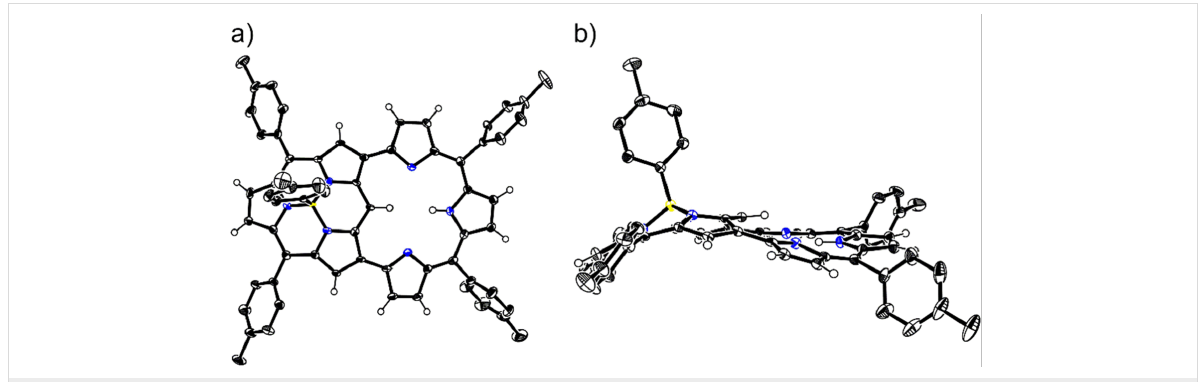
Figure 2: X-ray crystal structures of 3 : a) top view; b) side view. Thermal ellipsoids are drawn at the 50% probability level. All hydrogens on tolyl groups are omitted for clarity.